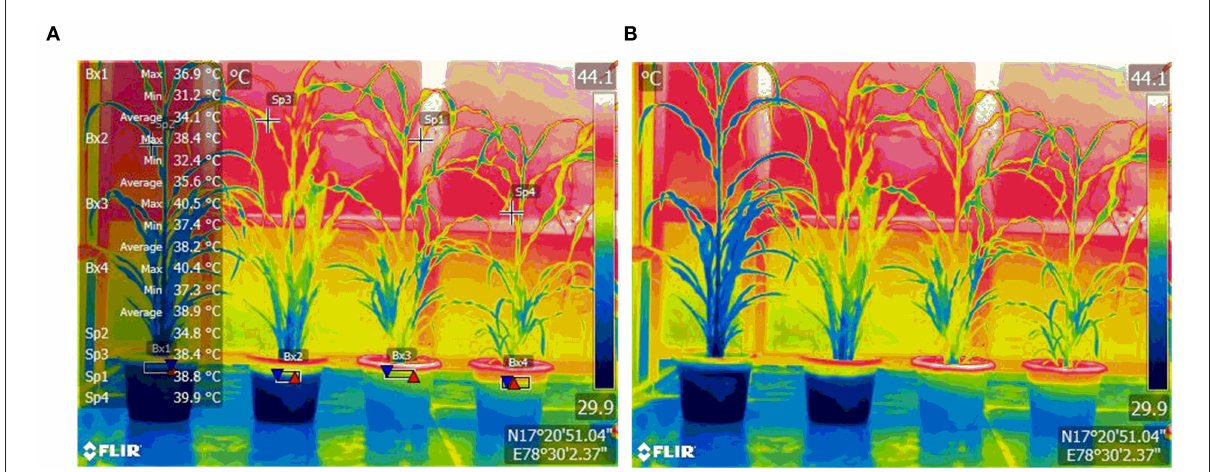
FIGURE1 Thermal image of pearl millet plants, Control (extreme left), and treated plants—Water-Deficit Stress, Heat Stress, and Water Deficit + Heat Stress (from left to right), with temperature annotations (A) and without temperature annotations (B) . Images were taken with Infra Red camera FLIR E-95 at a 4.9-meter distance from the plants. Temperatures of the plants are given as Maximum, Minimum, and mean. Boxes (Bx) show the temperature of the plant at the base, and Spots (Sp) show temperatures at specific spots.